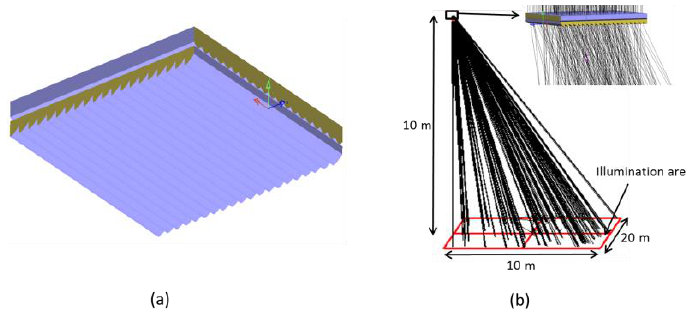
Figure 16. ( a ) The designed linear Fresnel lenses for street lighting purposes and ( b ) raytracing analysis of our proposed street lamp.